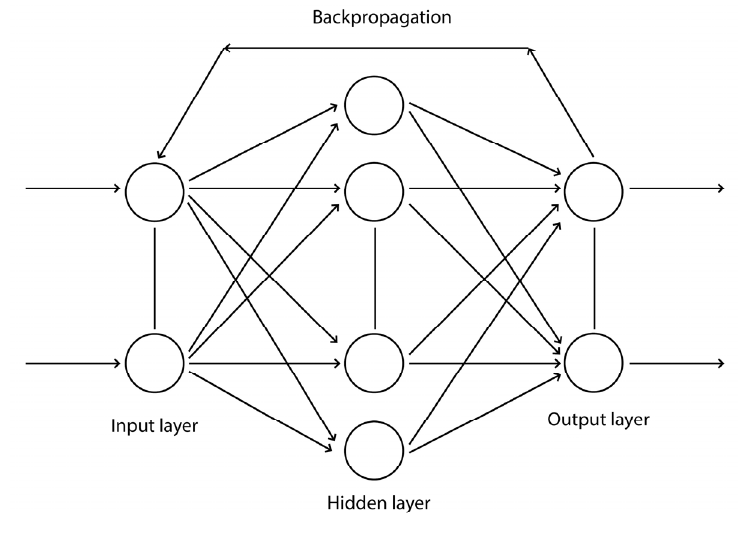
Figure 6. Structure of the neuron network of BP